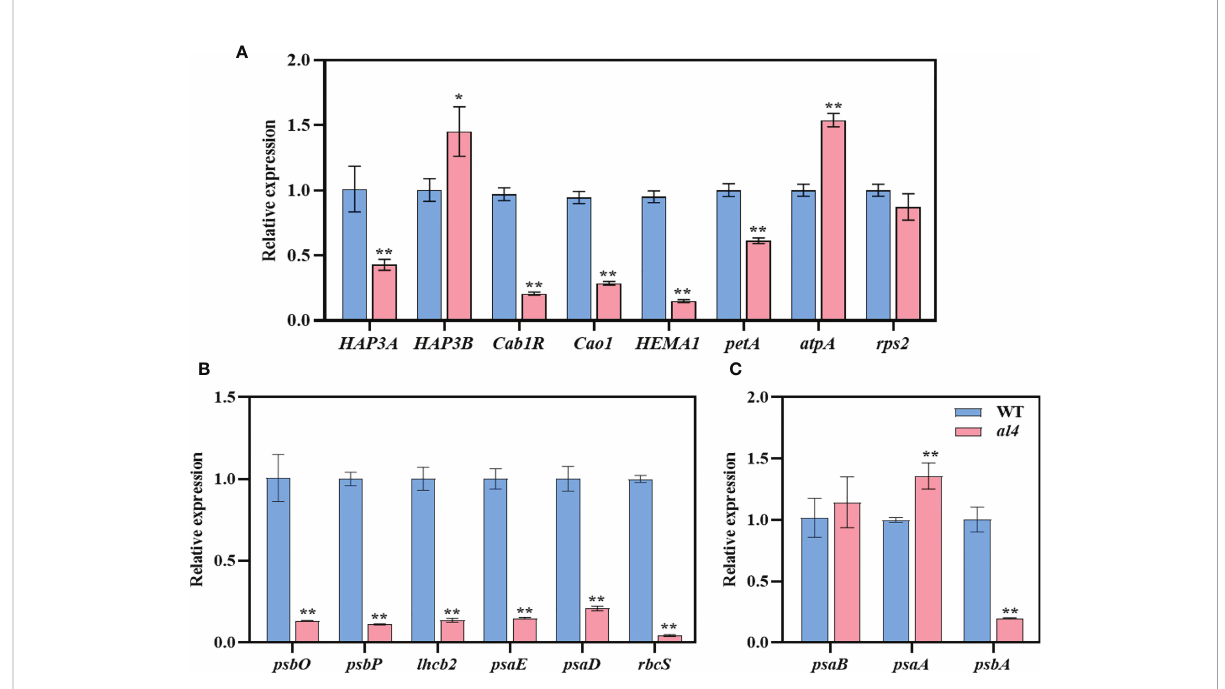
FIGURE 6 Expression of chloroplast-associated genes in WT and al4. Relative expression of chloroplast biosynthetic and translation related genes (A) , Photosynthetic associated nuclear genes (PhANGs) (B) , Plastid-encoded polymerases (PEPs)-dependent chloroplast genes (C) . Data are presented as mean ± S.D. * P < 0.05; ** P <